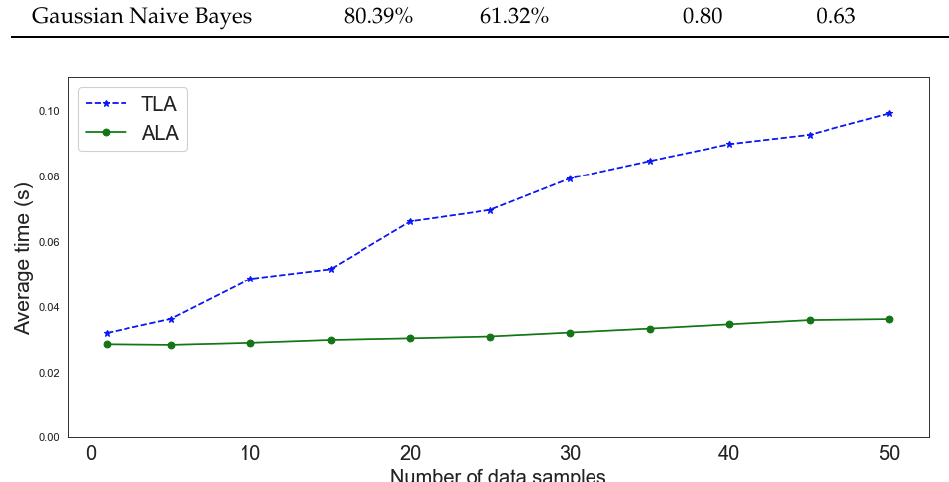
Figure 12. ML execution time on an ALA and a TLA. Experiment 2. To collaboratively train the ML models, the FEDn platform